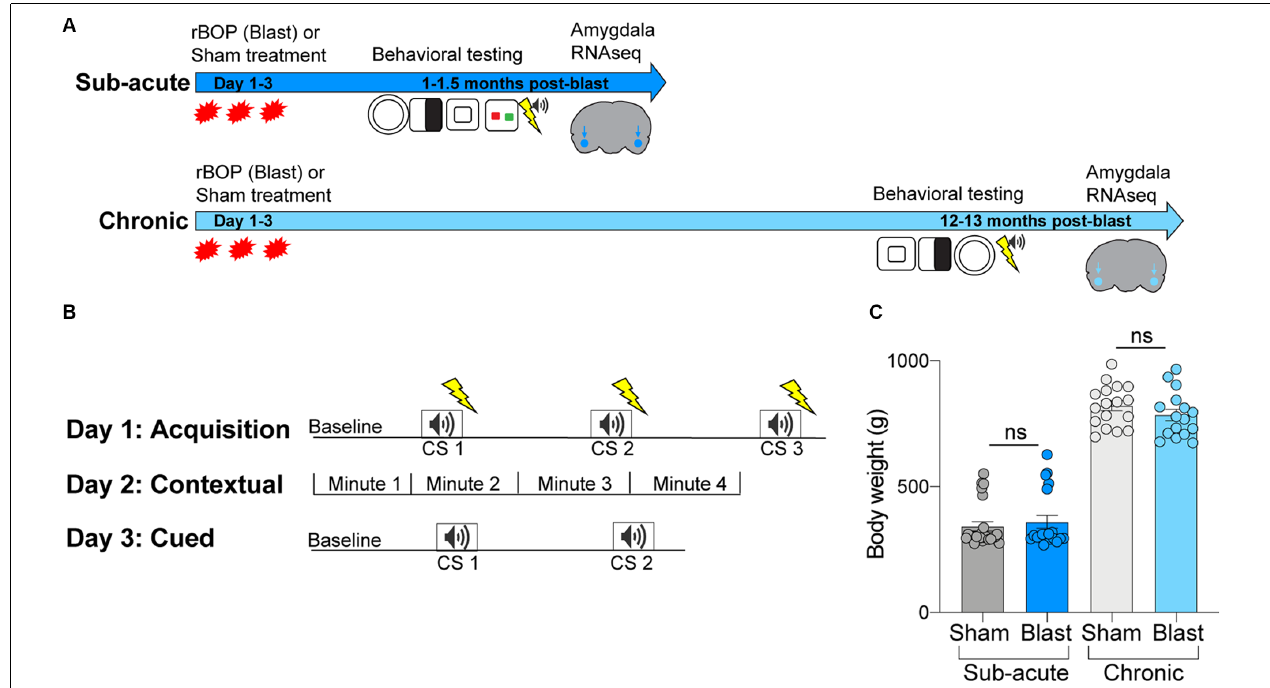
FIGURE 1 | Methodologies for blast exposure and behavioral testing. (A) Timeline for blast exposure, behavioral experiments, and tissue collection for the sub-acute and chronic cohorts. (B) Schematic of fear conditioning protocols, including acquisition, cued, and contextual fear conditioning. (C) Body weights of sub-acute and chronic cohorts at time of sacrifice (ns, not statistically significant; error bars represent